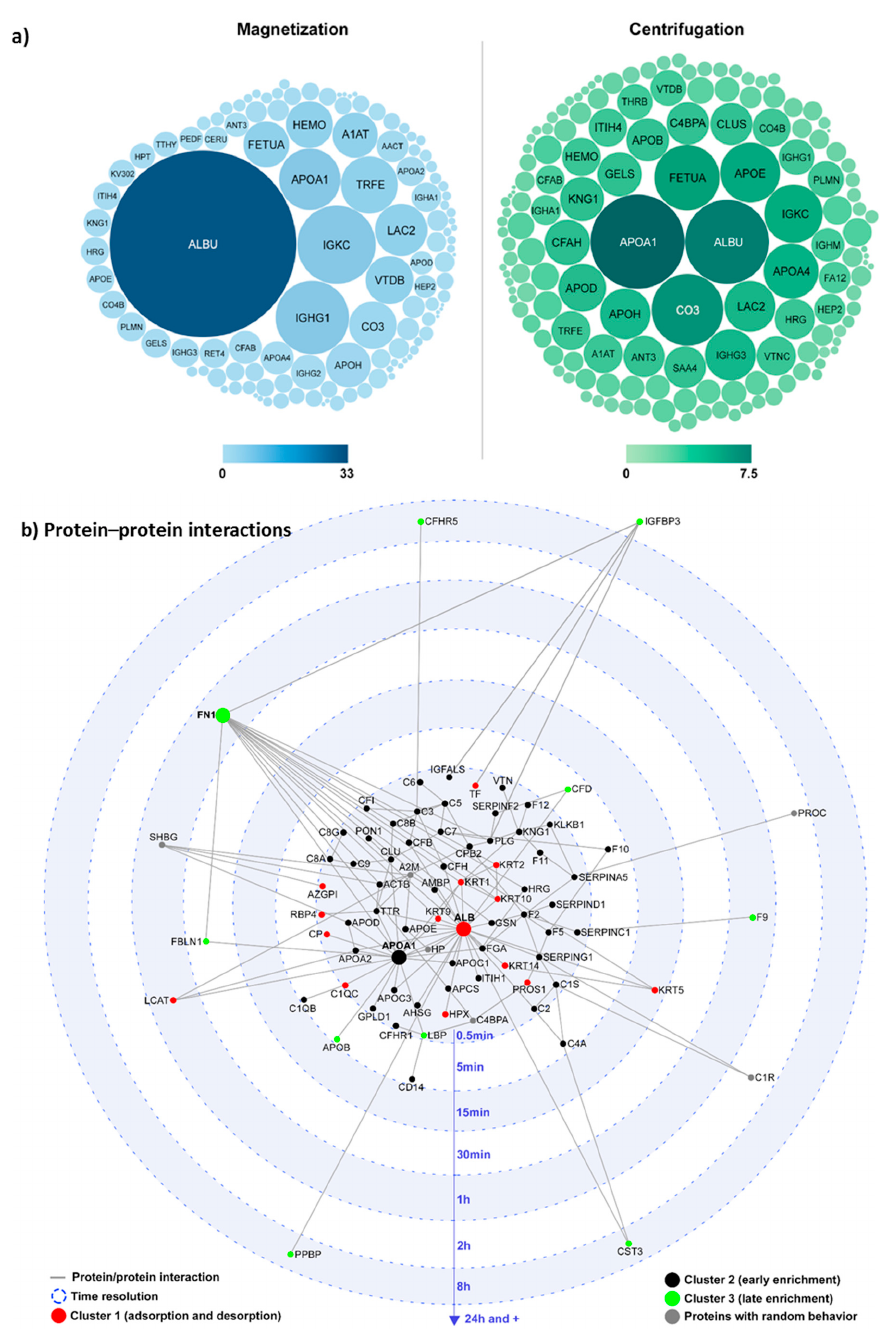
Figure 2. ( a ) Different proteomic profiles of the protein corona after Fe 3 O 4 @MSN separation by magnetization (blue) or centrifugation (green). Sizes and colors of human protein clues are proportional to their relative percentage within the corona. The 35 highest abundant proteins are labelled. The color scale unit is Normalized Spectral Abundance Factor (%). Reproduced from Pisani et al. 2017 [17] with permission from the Royal Society of Chemistry. ( b ) Protein–protein interactions are represented in a network developed using the NetworkAnalyst software [18,19], based on InnateDB [20]. The target represents the time scale (0.5 min to 7 days). Each protein (represented by its gene symbol) is placed according to its time of appearance within the corona. The colors indicate the cluster membership. The grey lines represent the protein–protein interactions. Proteins that have a lot of interactions with other proteins are represented by a larger visual cue. Reproduced from Pisani et al. 2017 [5] with permission from the Royal Society of